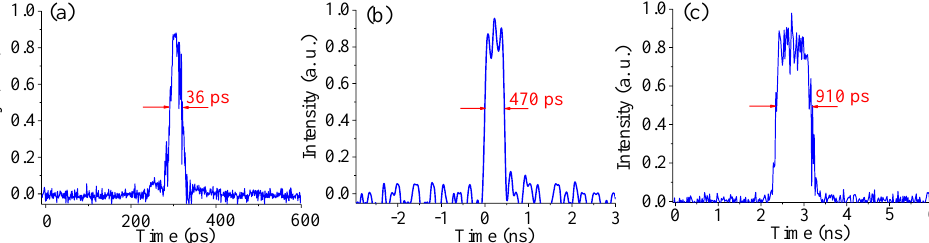
By tuning the PC, various mode-locking statuses are obtained, as shown in Figure 4. Under the same pump power of 200 mW, the pulse characteristics can be changed by solely tuning the PC. The pulse durations of 36 ps, 470 ps, and 910 ps were obtained corresponding to the average laser power of 9.8 mW, 10.3 mW, and 11 mW, respectively.